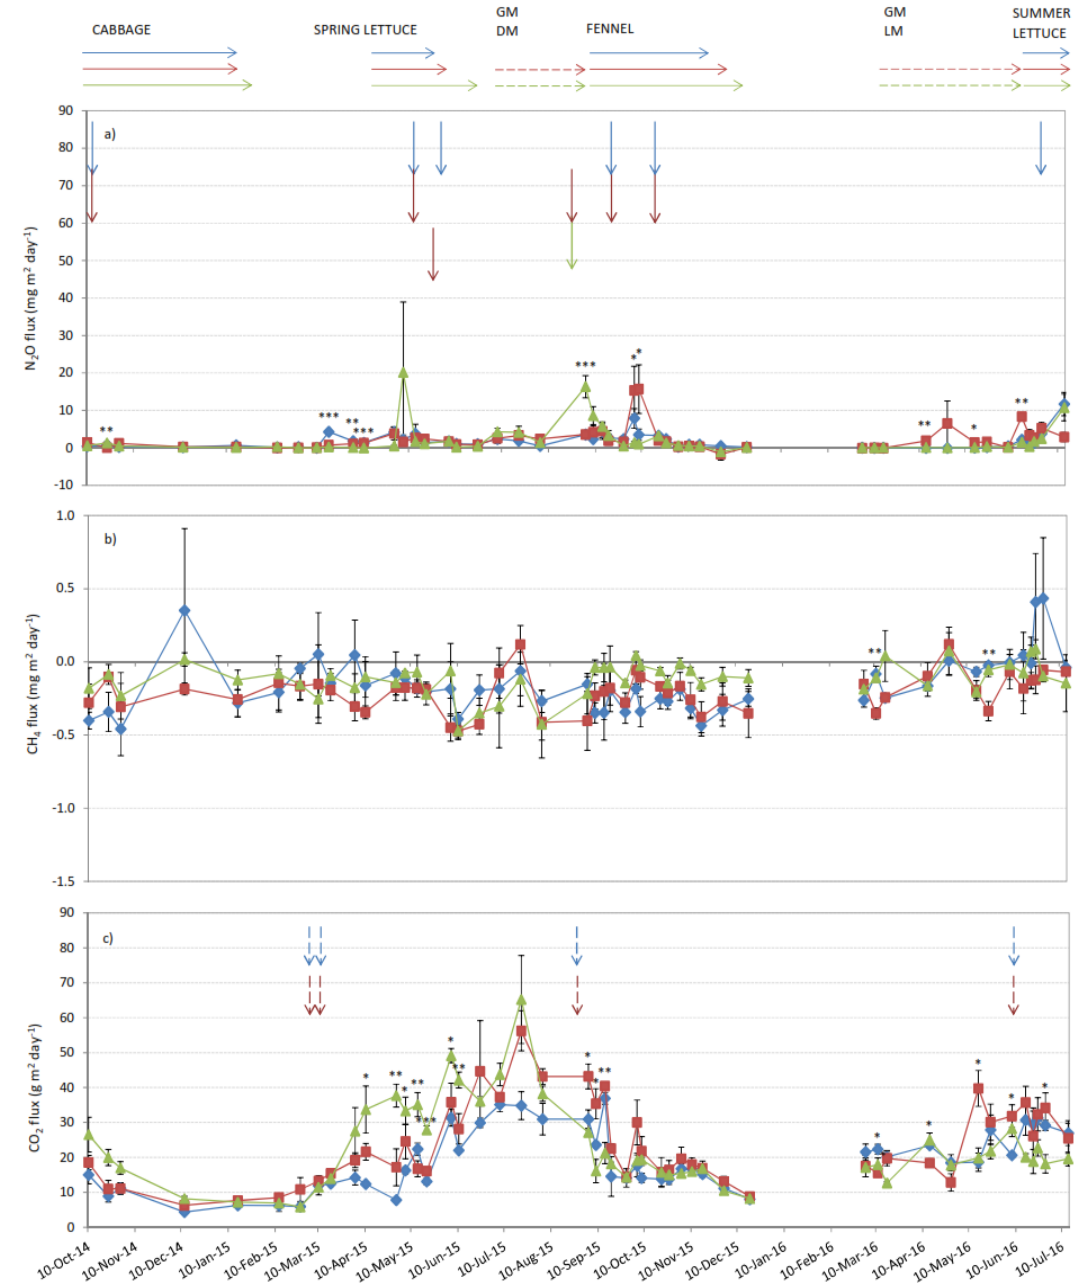
Figure 6. Daily average fluxes recorded in F2 of: ( a ) N 2 O; ( b ) CH 4 ; and ( c ) CO 2 for each treatment. Simple arrows indicate fertilization events; dashed arrows the primary tillage of each crop. On field 1 (F1) the temporal crop sequence was: Cabbage, spring lettuce, fennel, then summer lettuce. Significance was as follows: n.s. is not significant; * is significant at the p ≤ 0.05 level; ** is significant at p ≤ 0.01 level; *** is significant at p ≤ 0.001 level.